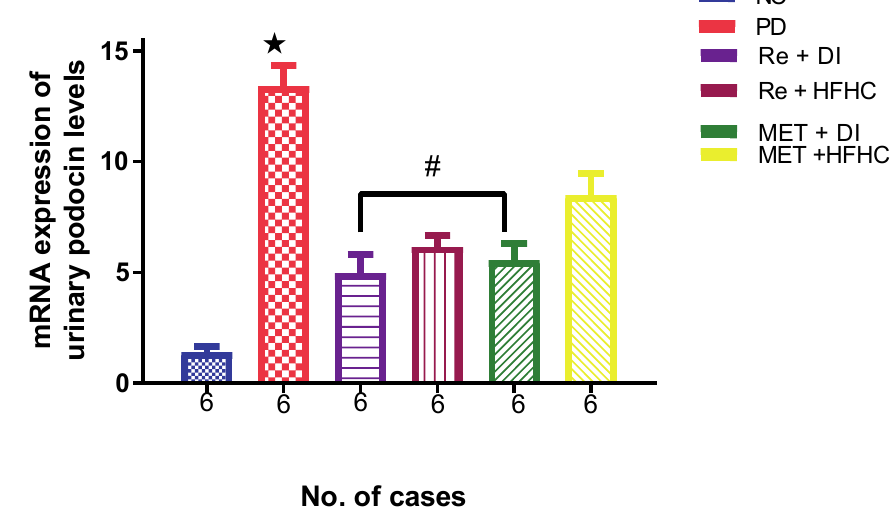
Figure 19. Levels of mRNA expression of urinary podocin in normal control (NC), prediabetic control (PD), metformin and diet intervention (MET + DI), metformin and high-fat/high-carbohydrate diet (MET + HFHC), rhenium (V) compound and diet intervention (Re + DI) and rhenium (V) compound and high-fat/high-carbohydrate (Re + HFHC) groups after 12 weeks of treatment. Values are presented as means ± SEM (n = 6). (cid:70) p < 0.05 in comparison with NC; # p < 0.05 in comparison with PC, MET + DI, MET + HFHC, Re + DI and Re +